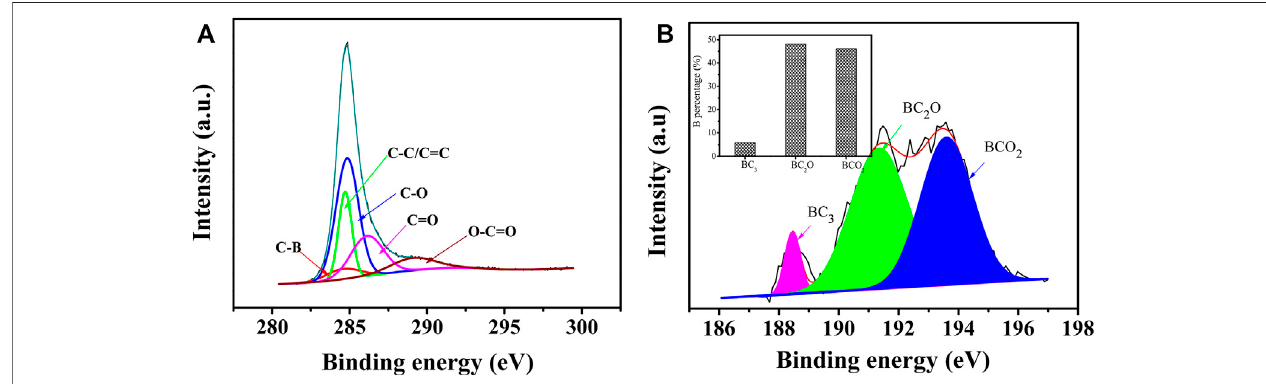
type-IV isotherms (Li et al., 2020). A clear hysteresis loop within a